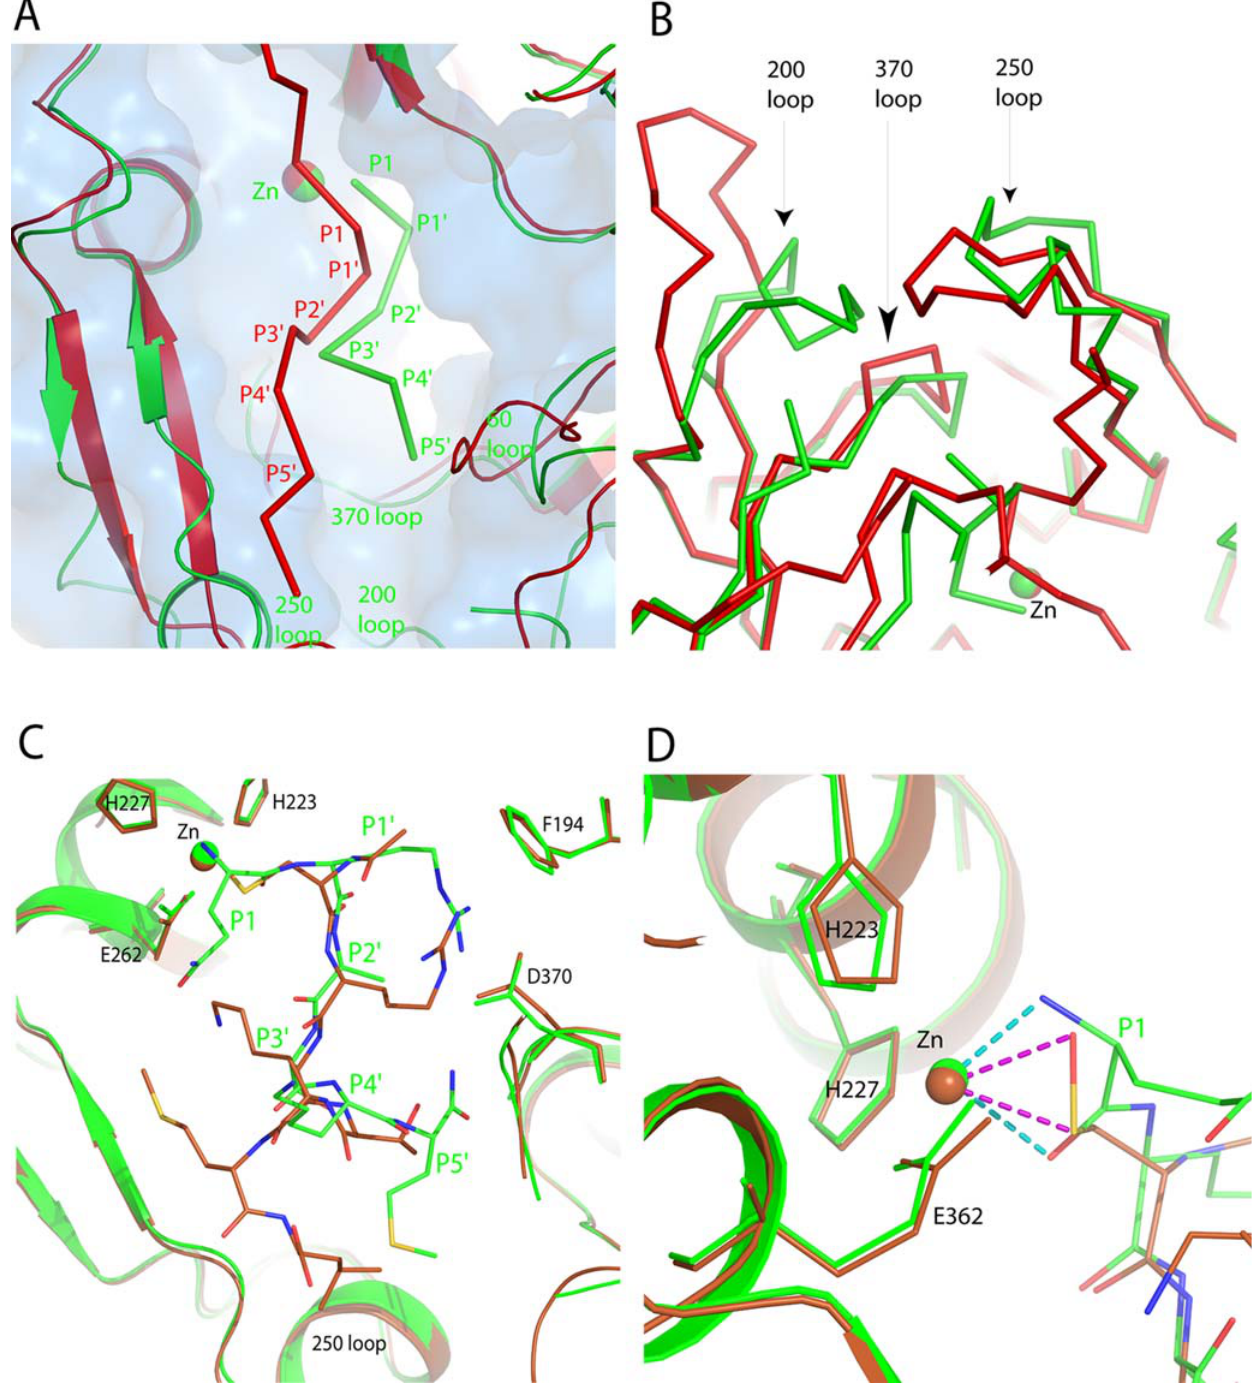
Figure 5. Comparison of Balc424 complexed with segments of SNAP-25 (197–202) and (146–204) and an inhibitor (N-Ac-CRATKML). (A) and (B) show the superposition of Balc424 with SNAP-25 (197–202) and (146–204). Green and red represent SNAP-25 (197–202) and SNAP-25 (146–204), respectively. Superposition of Balc424 with substrate peptide (SNAP-25 [197–202]) and N-Ac-CRATKML peptide at the vicinity of the active site are shown in C and D. N-Ac-CRATKML peptide complex is shown in brown color. Zinc binding and selective substrate binding residues are in stick model.